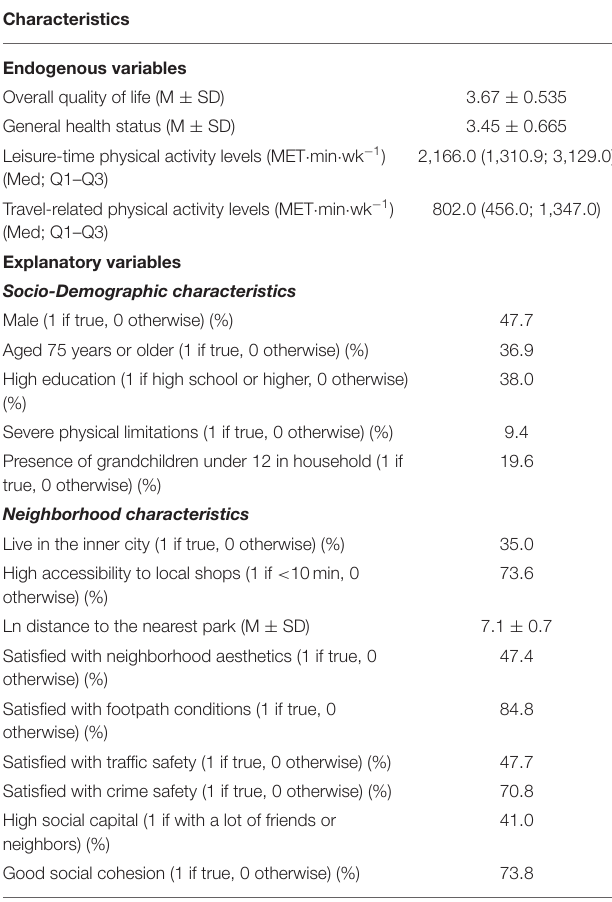
TABLE 1 | Descriptive statistics of the sample ( N = 363 respondents).